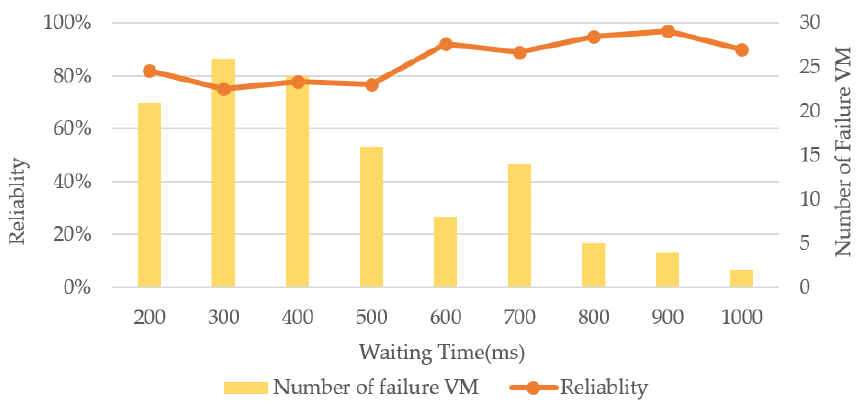
Figure 7. WT / reliability trade-o ff Figure 7. WT/reliability trade-off.